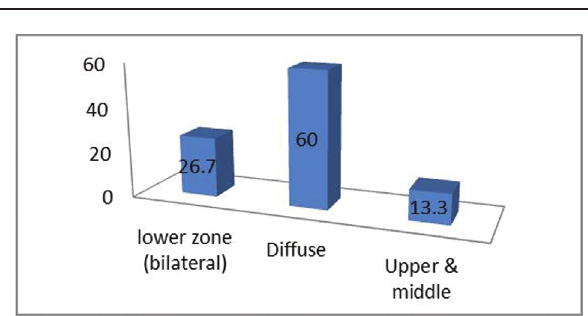
Chest radiography findings (radiological distribution of abnormality in the radiography) of studied